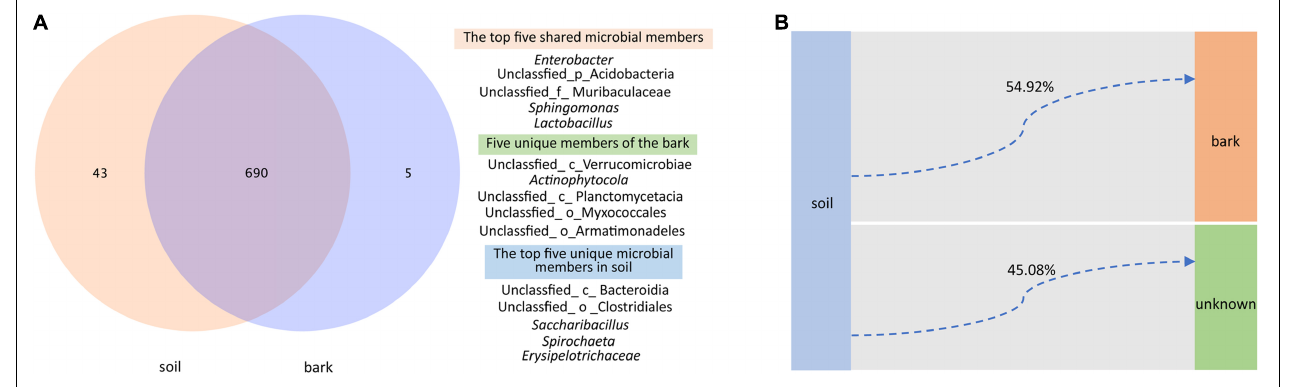
FIGURE 3 | Genus-level differences and potential source tracking of rhizosphere soil and bark bacterial communities. (A) Venn diagrams showing shared and unique bacterial genera in different niches. (B) FEAST showing that the rhizosphere soil bacterial community was a potential source of the bark bacterial